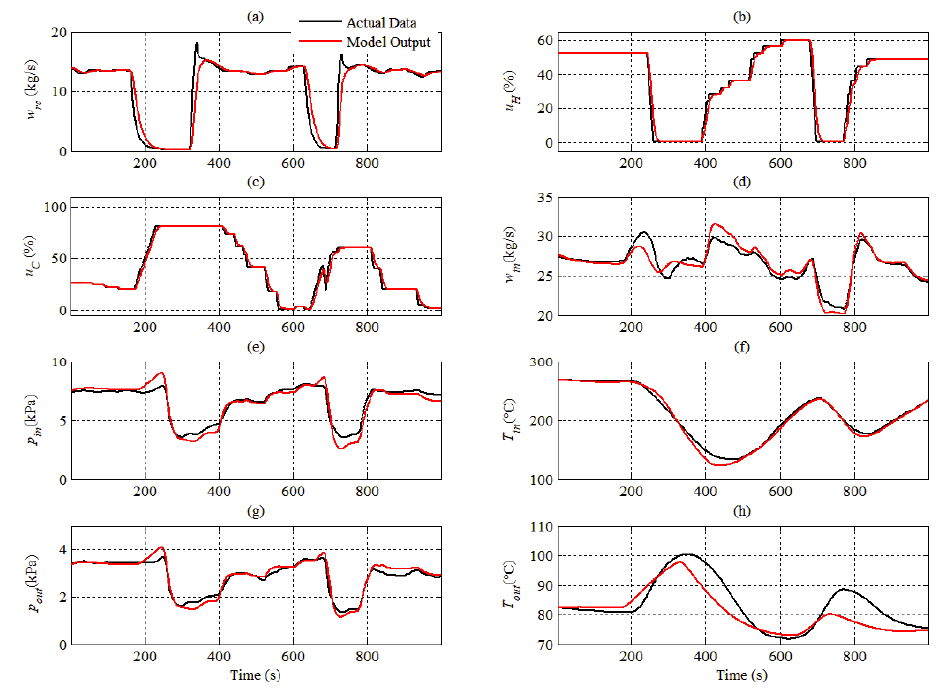
Figure 4. Simulation of coal interruption